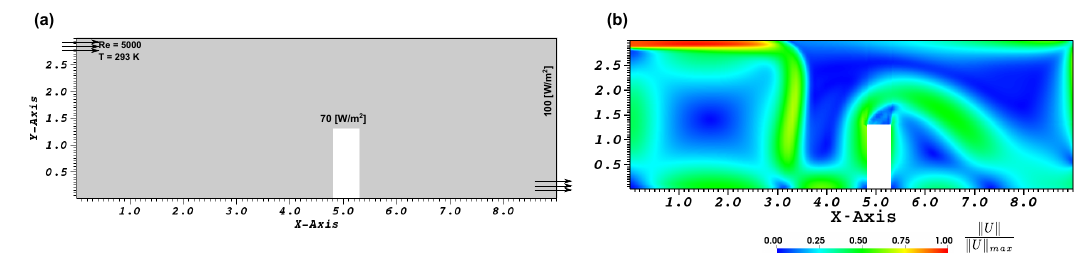
Figure 3. ( a ) Geometry and boundary conditions are used for computing the velocity flow field. ( b ) The velocity magnitude computed and used for computing the transfer operator.